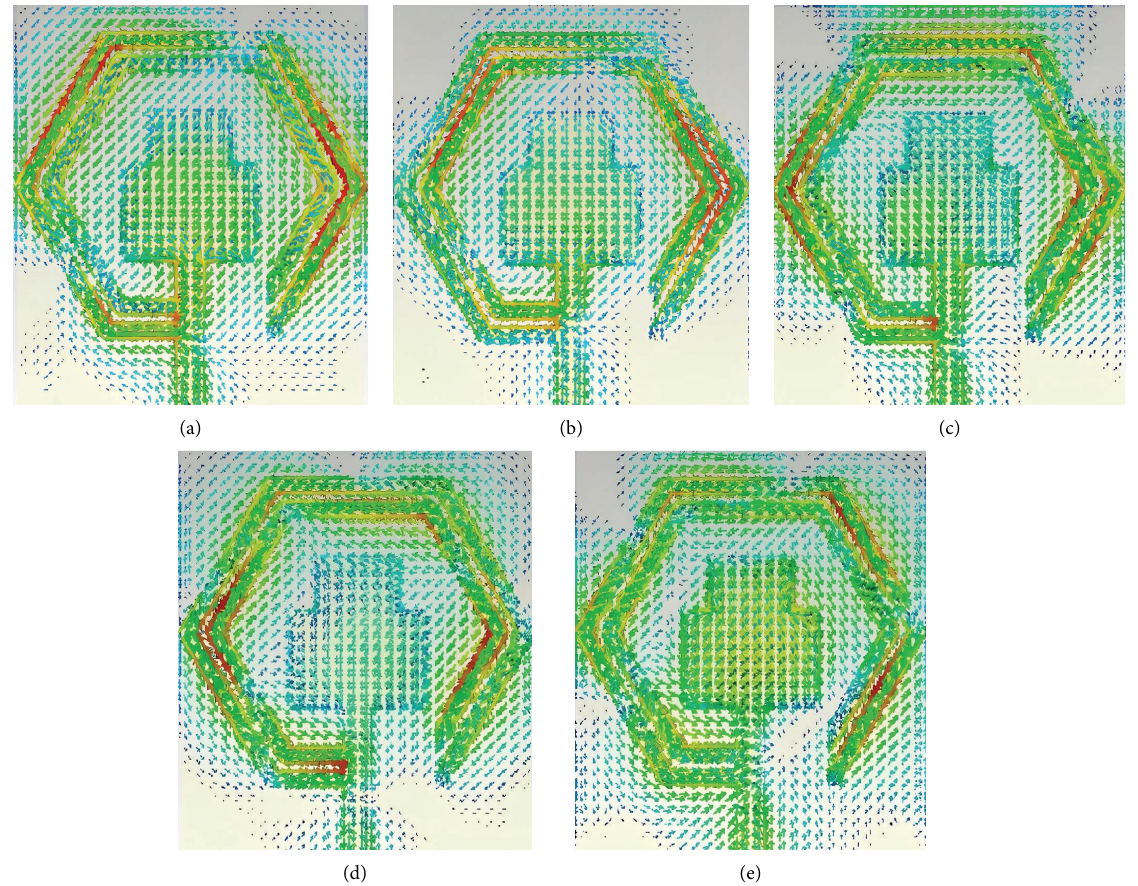
Figure 9: Distribution of surface current on the proposed low-SAR penta-band microstrip patch antenna. (a) 3.01GHz. (b) 3.83